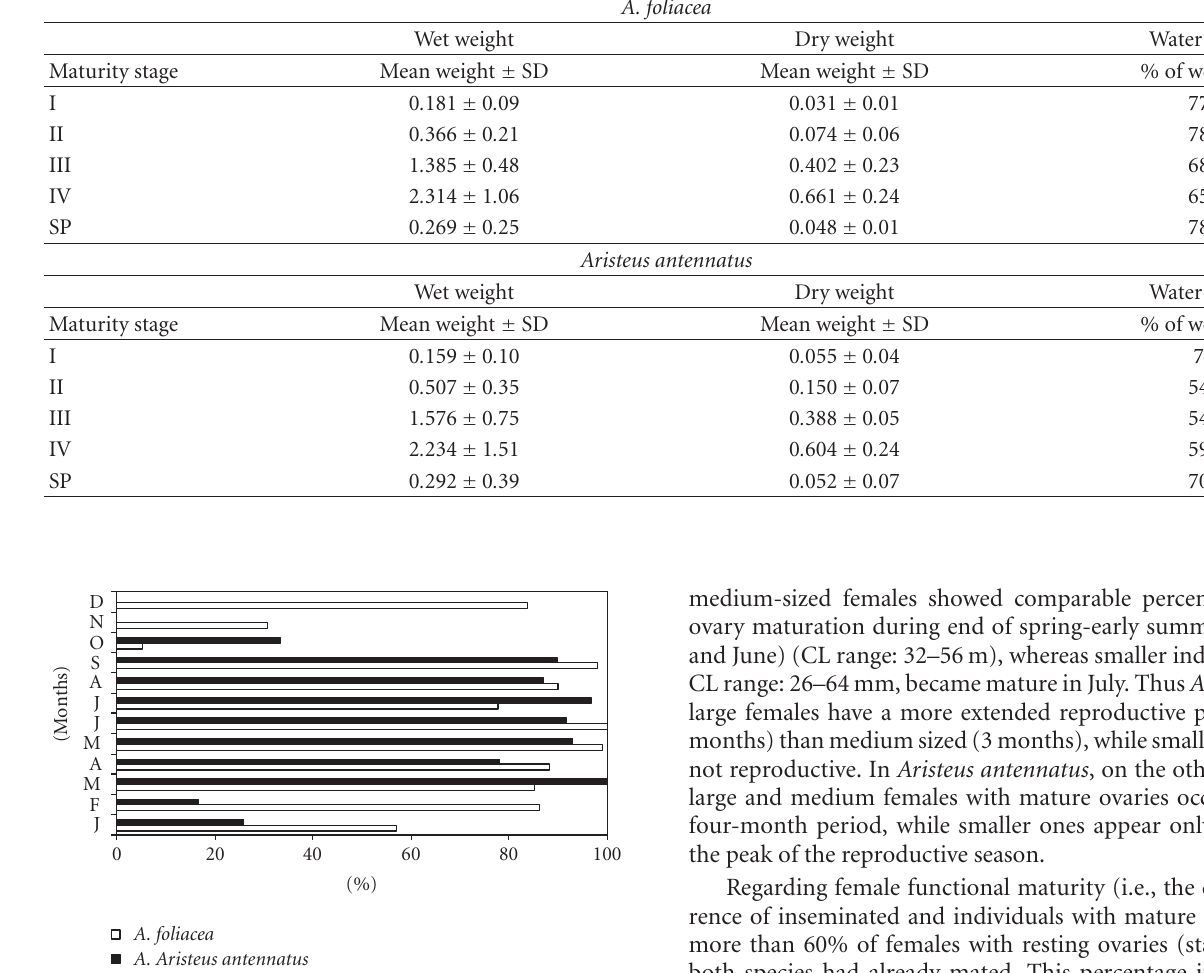
Figure 2: Monthly spermatophore occurrence in Aristaeomorpha foliacea and Aristeus antennatus females from the eastern Ionian Sea.